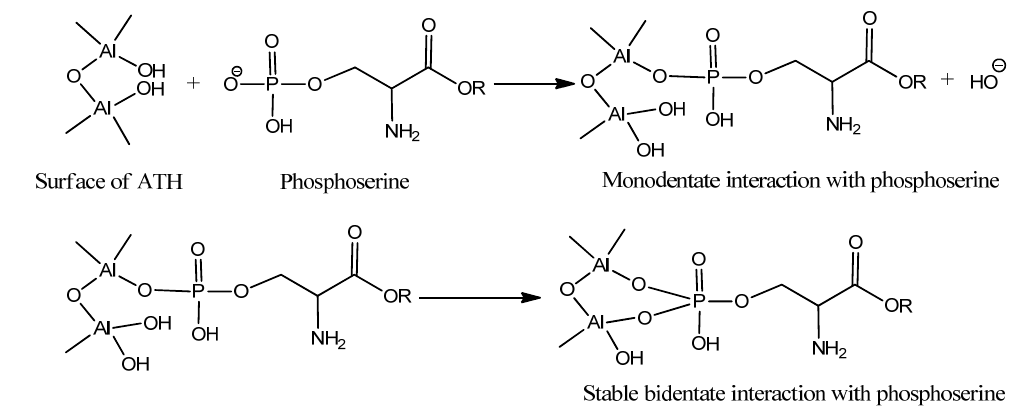
Figure 3. The inner sphere complex formation reactions between an aluminum ion and a phosphate group in casein.